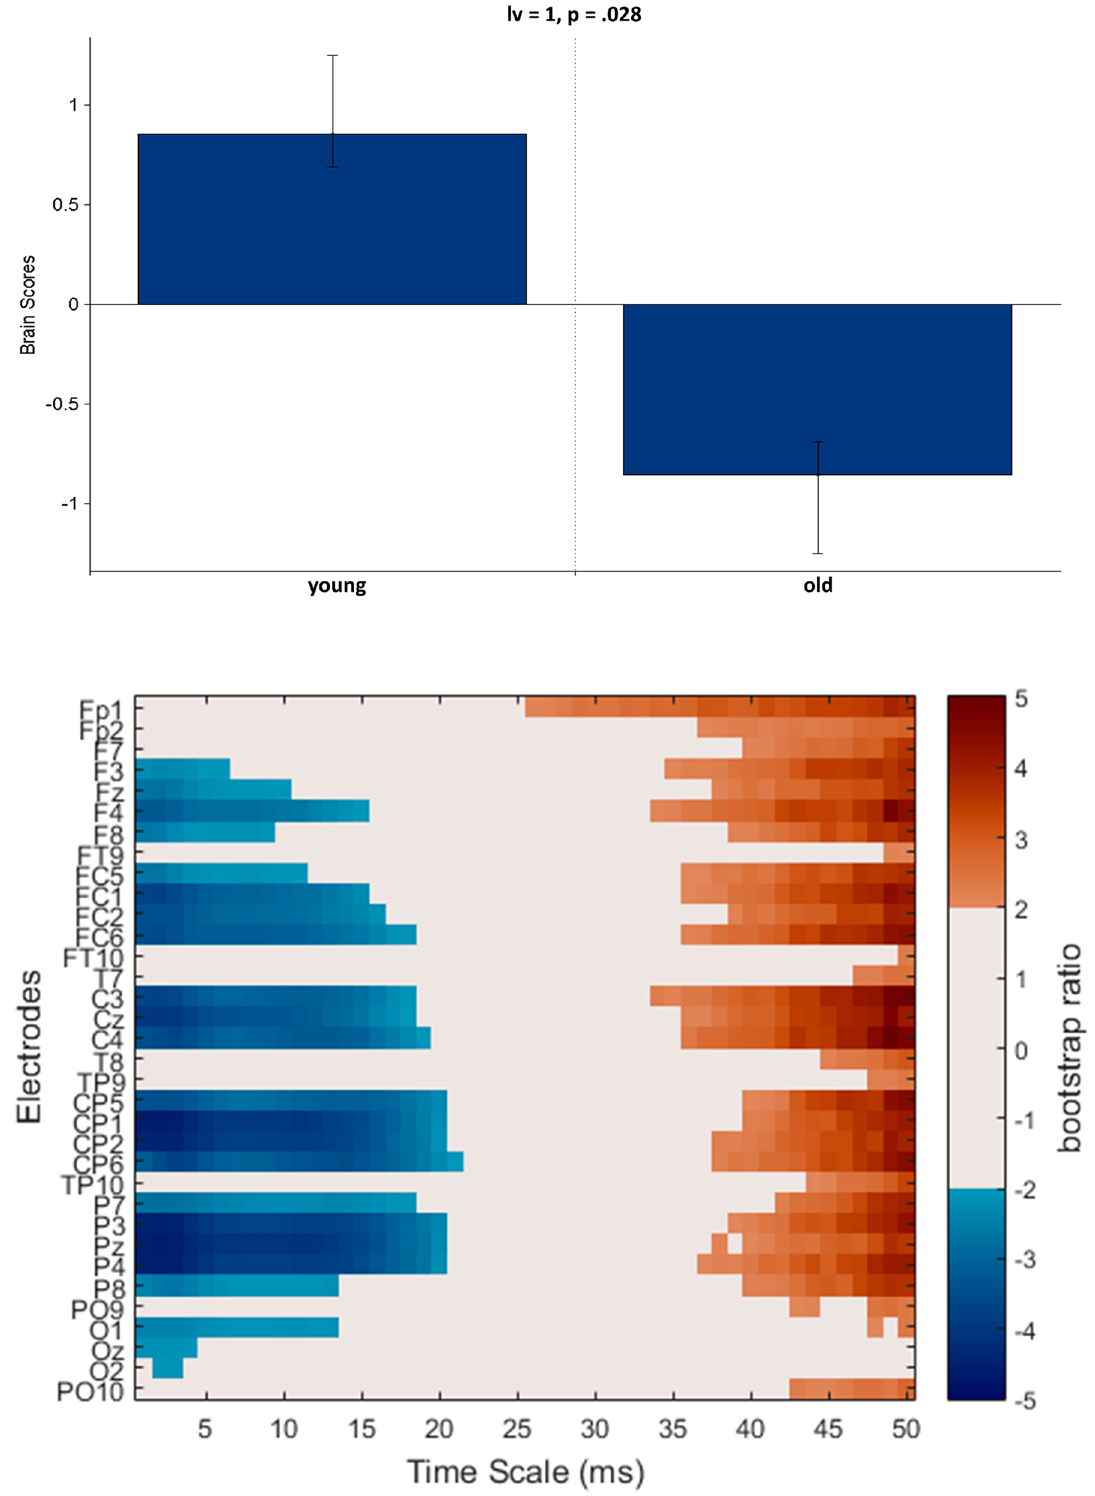
Figure 4. PLS analysis results for the general aging effect on MSE (using the pre-training resting state in our two age-groups). (Top) The bar graph depicts the contrast between age-groups that was significantly expressed across electrodes and timescales as determined by permutation tests, with error bars denoting 95% confidence intervals. (Bottom) The bootstrap ratio map illustrates the electrodes and timescales at which the contrast displayed in the bar graphs was most stable. Values represent the ratio of the individual electrode weights and the bootstrap-derived standard error (roughly z scores, thresholded at 2.0 which corresponds approximately to p < 0.05). Positive values are plotted in warm clours and indicate timescales and electrodes showing decreases from young to old age-group in resting state MSE. Negative values are plotted in cool colours and denote increases from young to old age-group in resting state